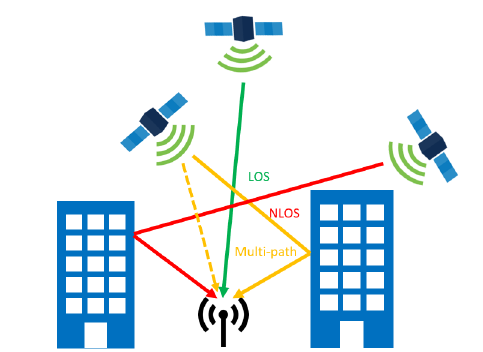
Figure 2. Schemes of the multipath and NLOS